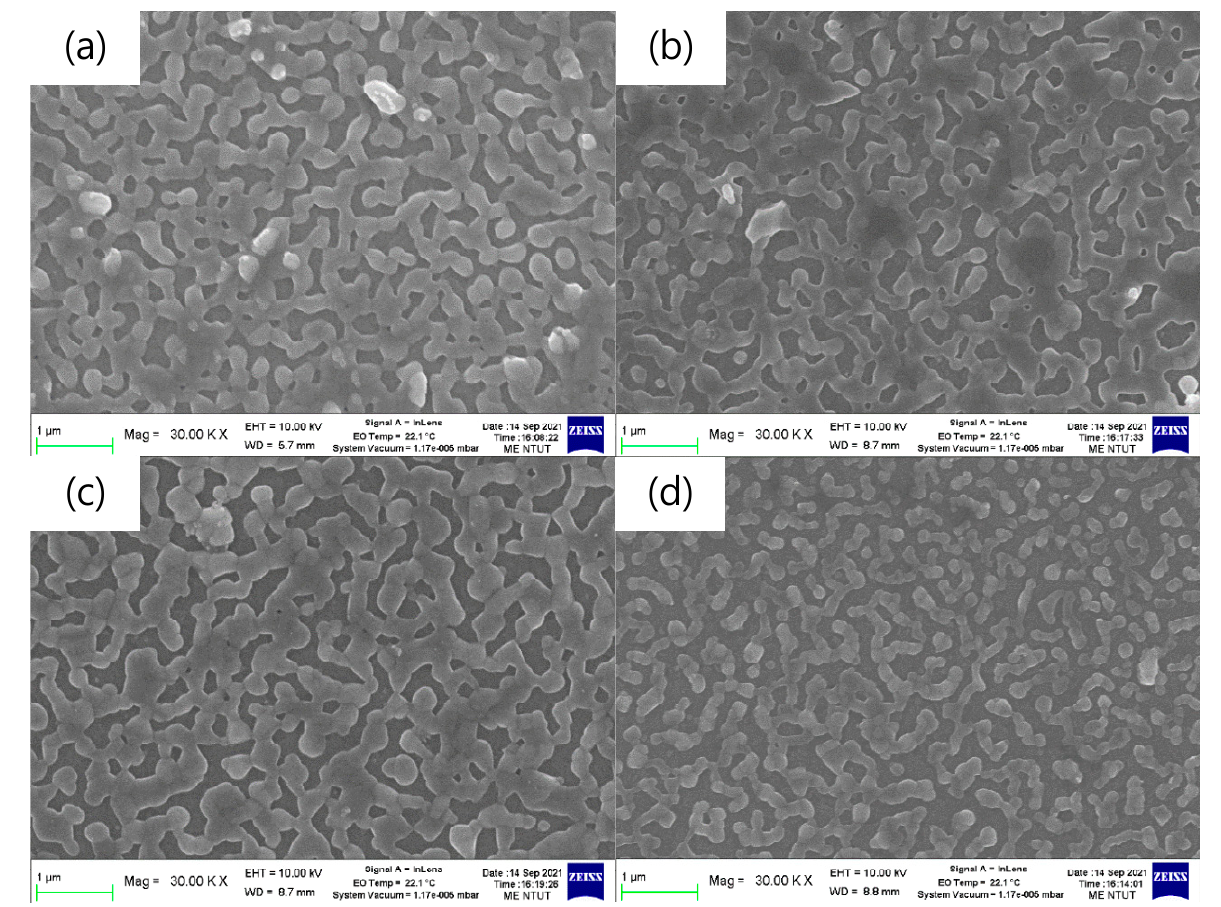
Figure 2. Top-view SEM images of the pa-ZnO-doped CsPbBr 3 perovskite films on glass substrates with various amounts of pa-ZnO nanopowder: ( a ) 1 mg, ( b ) 2 mg, ( c ) 5 mg, and ( d ) 10 mg.